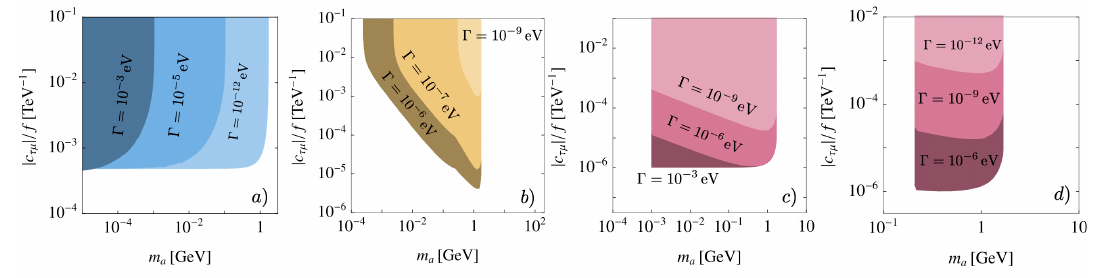
Figure 37 . Constraints on the flavor-violating ALP couplings c τµ from tau decays, collected in table 2, for different values of the total ALP width. The color-coding indicates the final state: blue for invisible final states, yellow for ALP decays into photons, and red for a → e + e − and a → µ + µ − decays.